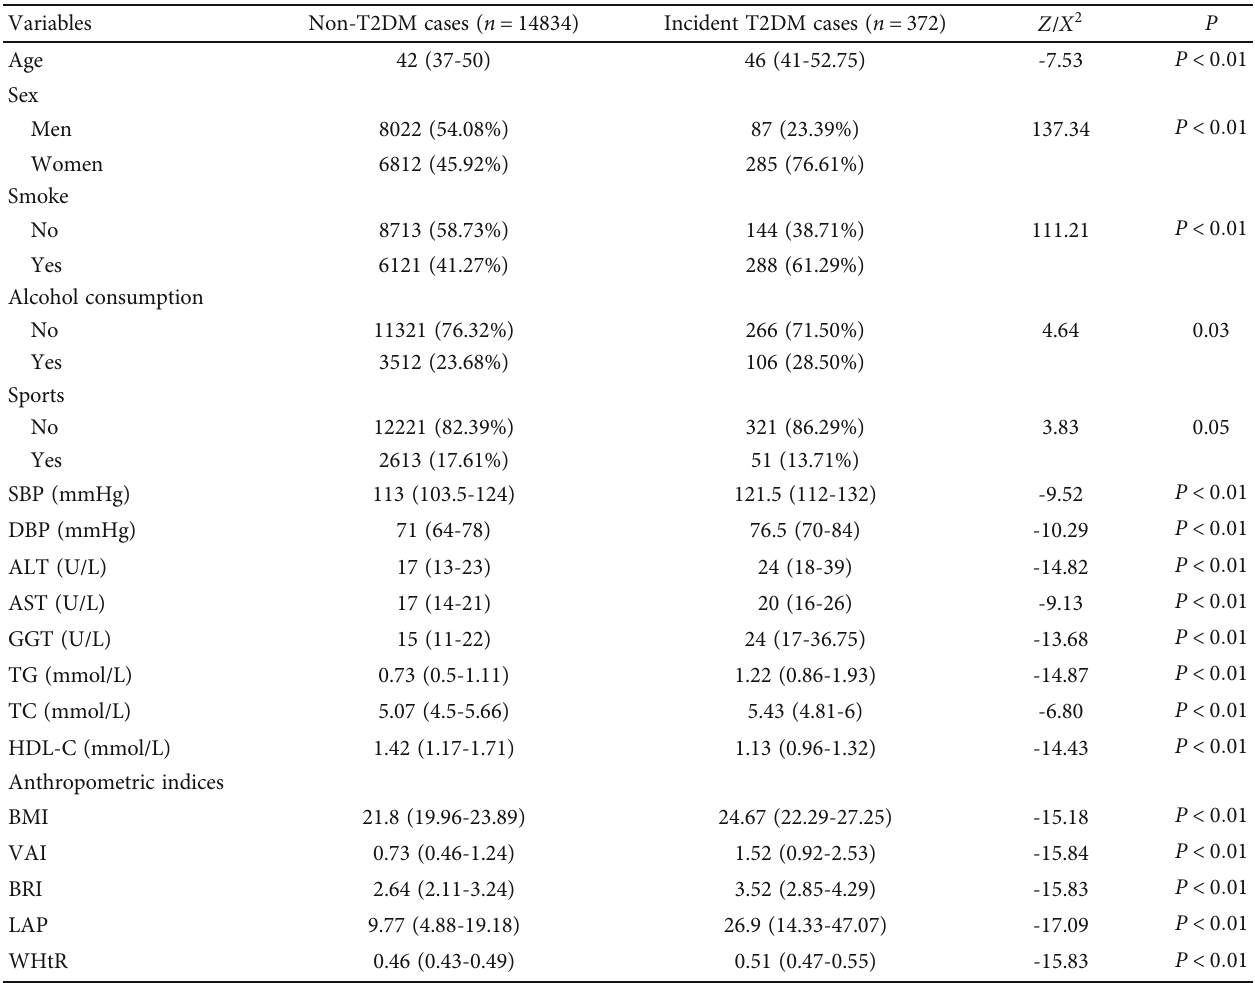
Table 1: Comparison of baseline characteristics between the T2DM and non-T2DM groups.